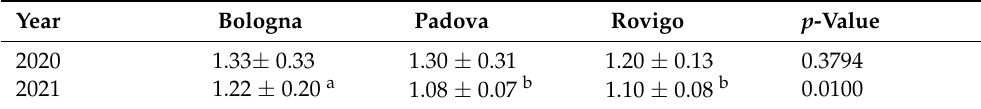
Table 3. Viscosity values (mPa · s) in sorghum from different locations and years ( n = 15 per location and year; mean ±